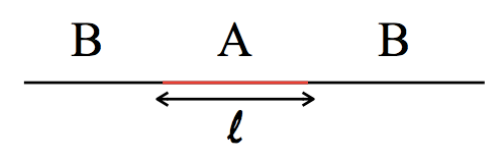
Figure 1: Typical bi-partition for the EE of one in- terval.